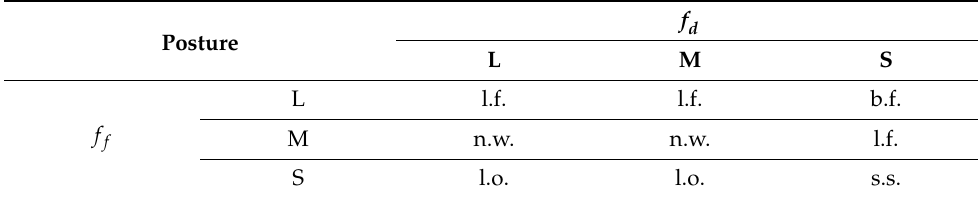
Table 4. Posture while moving downhill. Posture